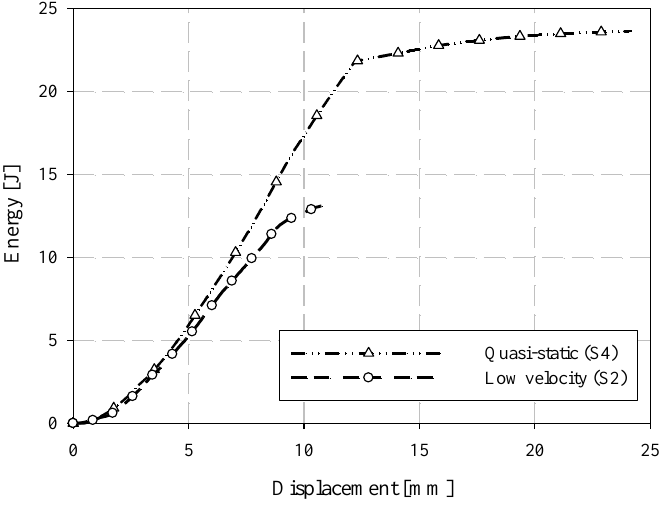
Figure 18. Comparison of quasi-static and low-velocity puncture energy-deflection responses. Imagery of the specimen faces opposite to the indenter is compared between loading rates in Figure 19. Note that the quasi-static images are not as perpendicular to the face of the undeformed specimen since the images are acquired from one of the two cameras of a DIC system with an angle between the cameras sufficient to resolve out-of-plane displace- ments. A crack is visible at approximately 2 mm of quasi-static crosshead displace- ment. Under low-velocity impact loading, a crack appears at a dramatically lower magni- tude of deflection, that being approximately 0.1 mm. This observation may be a further